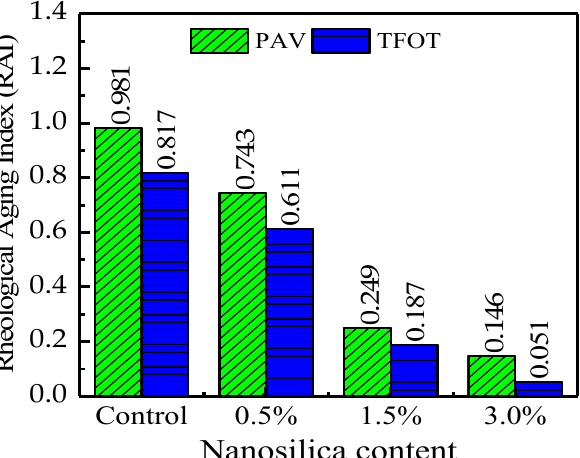
Figure 8. Rheological aging index terminal blend rubberized asphalt with different contents of nano ‐ silica.